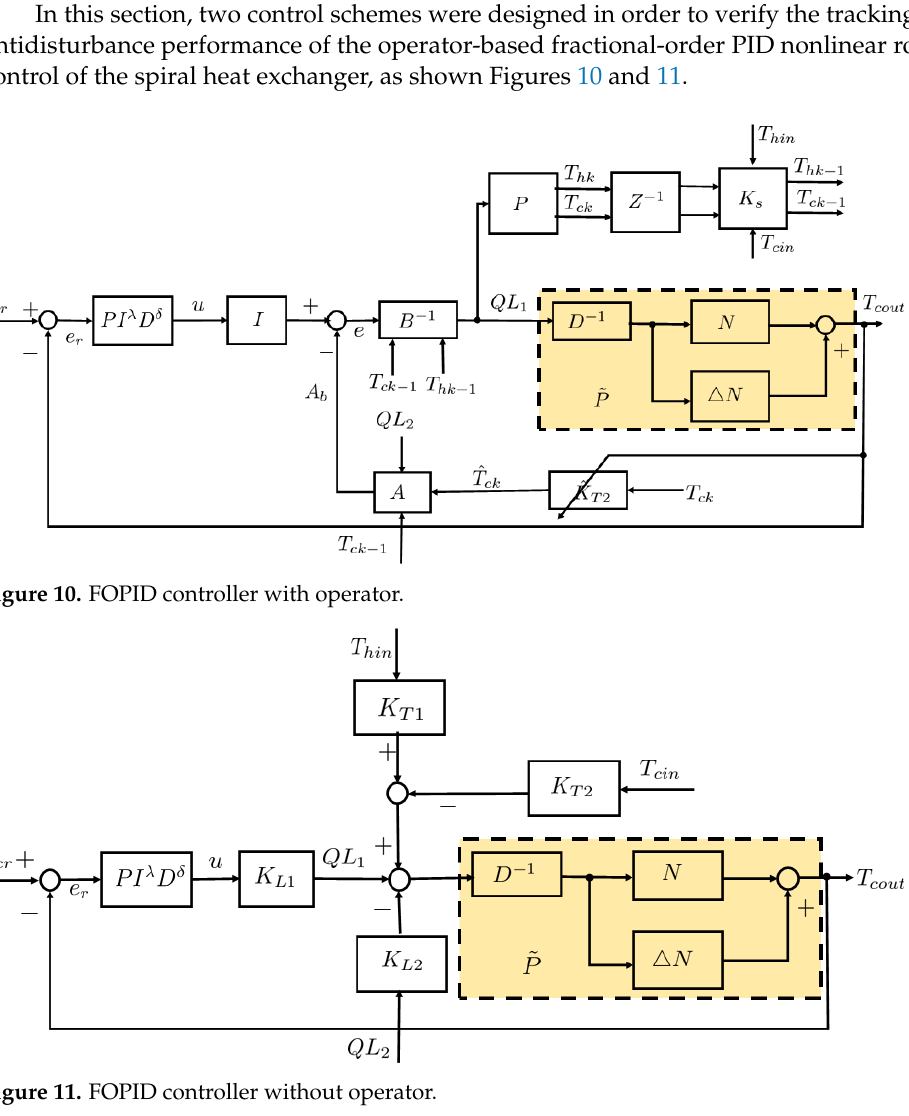
Figure 11. FOPID controller without